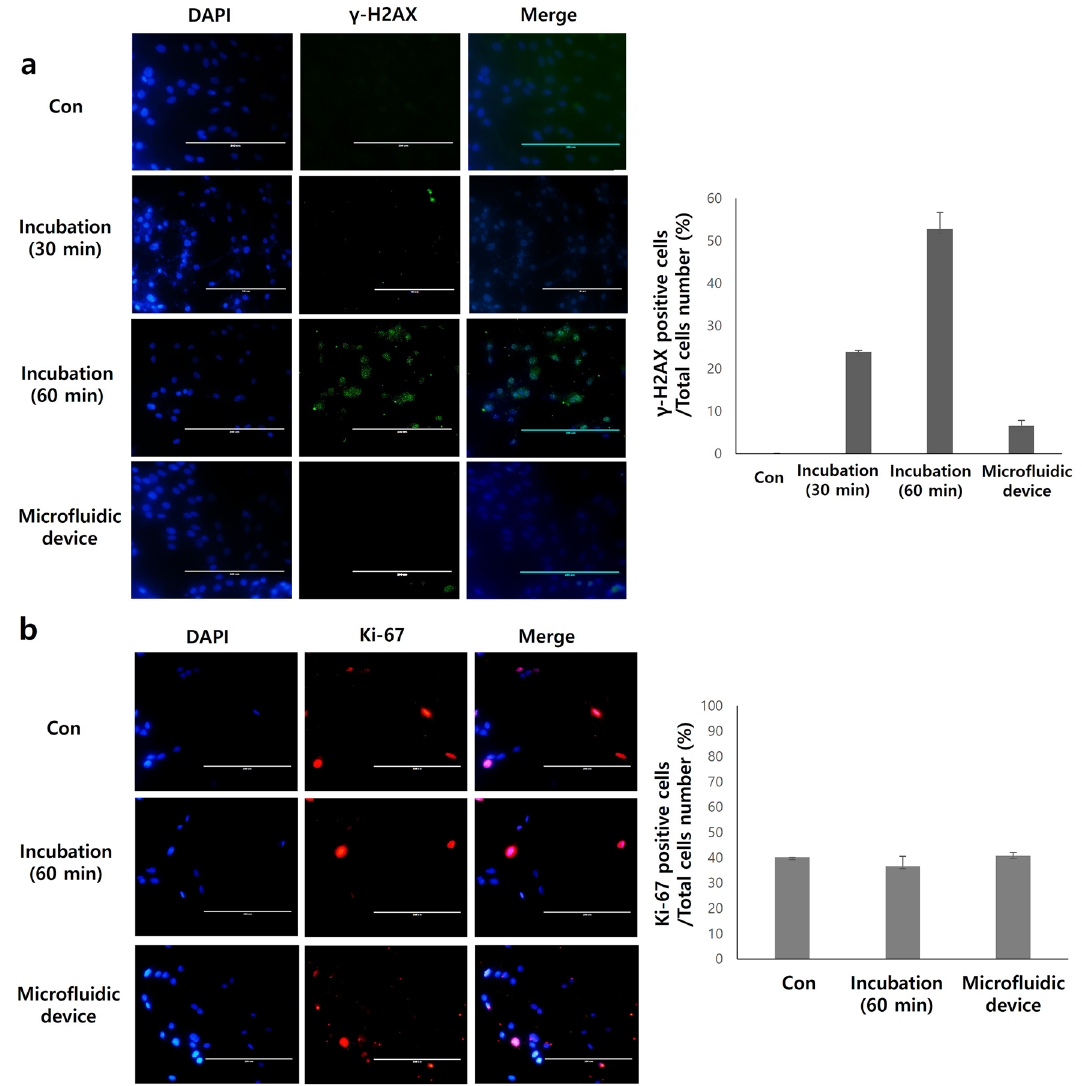
Figure 4. Cell biocompatibility assays. ( a ) γH2AX staining showing DNA damage (double strand breaks) in labeled ADSCs after 30 min, 60 min passive incubation or microfluidic device. ( b ) Ki-67 staining showed no significant difference in proliferation between control, unlabeled and labeled